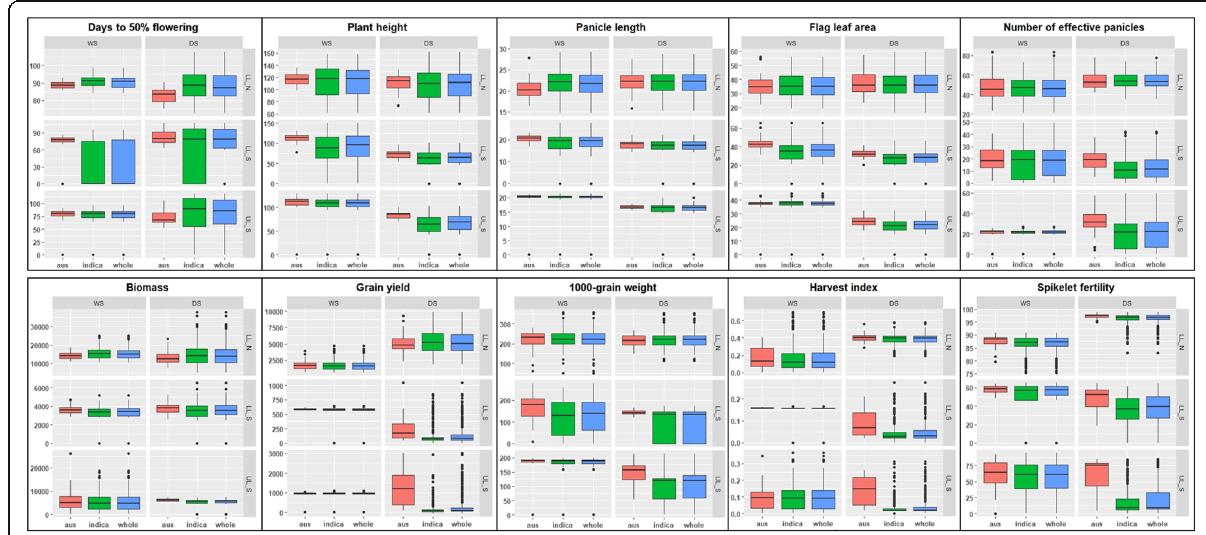
Fig. 1 Boxplots of ten phenotypic variables within diverse set. Days to 50% flowering, Plant height (cm), Panicle length (cm), Flag leaf area (cm 2 ), Number of effective panicles, Biomass dry weight at maturity (kg ha − 1 ), Grain yield (kg ha -1 ), 1000 grain weight (g), Harvest index and Spikelet fertility (percentage ratio by weight) for each of the six experiments (lowland non stress-LL_N, lowland stress-LL_S and upland stress-UL_S) in the two seasons- wet season-WS and dry season-DS. The boxplots are divided into population and subpopulation levels for each trait-whole population level (with all 280 indica-aus accessions): 245 accessions representing the four major genetic subgroups of indica genetic background and 35 accessions of aus genetic background. Within the boxplots, bold line represents the median, box edges represent upper and lower quantiles, and whiskers are 1.5 times the quantile of the data. Open dots represent the